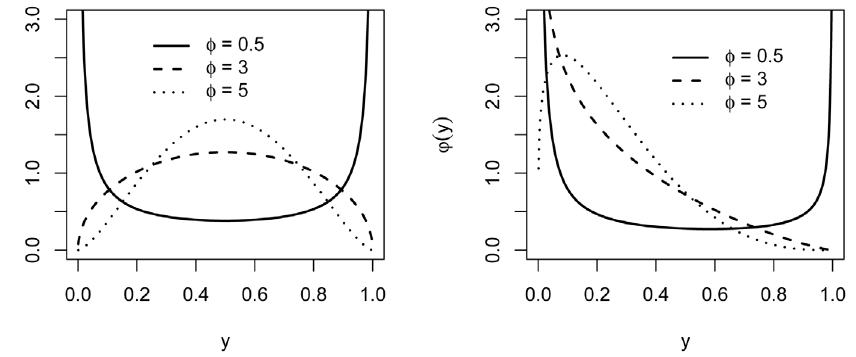
Figure 1. Probability density functions for beta distributions. Probability density functions for beta distributions with m ~ 0 : 5 (left) and m ~ 0 : 25 (right).